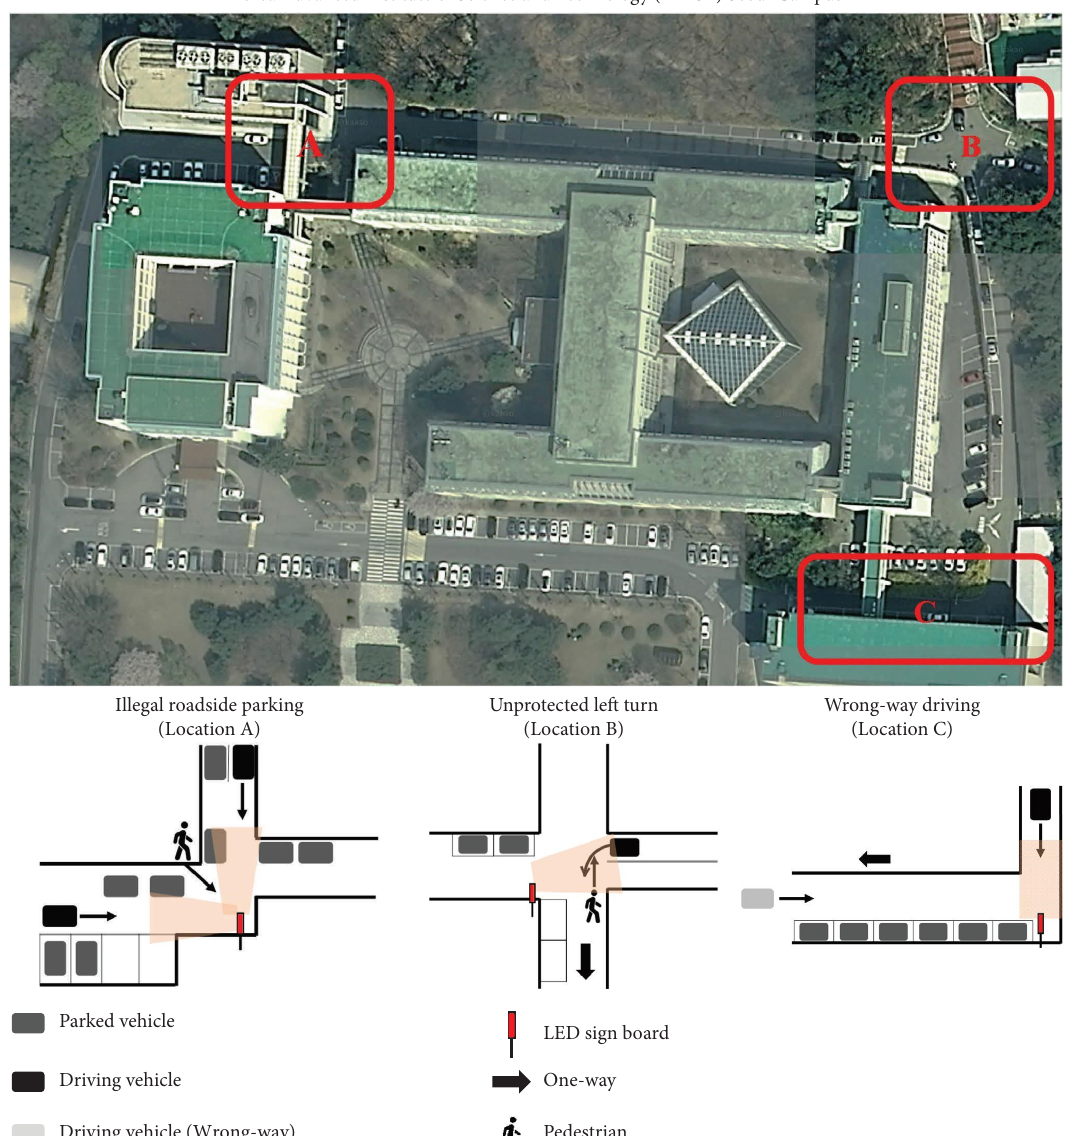
Figure 9: Site description: the proposed service was applied to three diferent locations on KAIST Seoul Campus. Each location was chosen for a single specifc risk circumstance: Location A for illegal roadside parking; Location B for unprotected left turn; and Location C for wrong-way